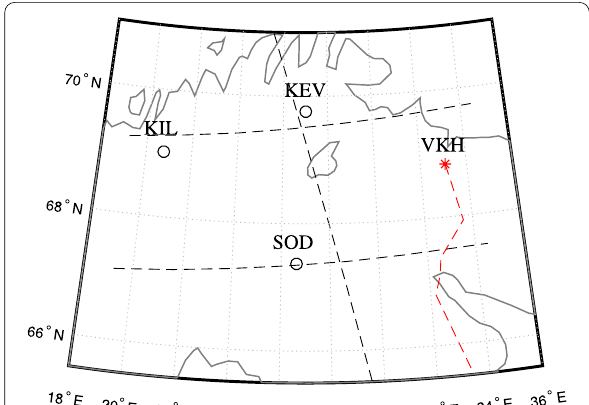
Fig. 1 Locations of the magnetic observatories, the observational point of GIC recording at VKH. The electric power line is schematically shown with a red dashed